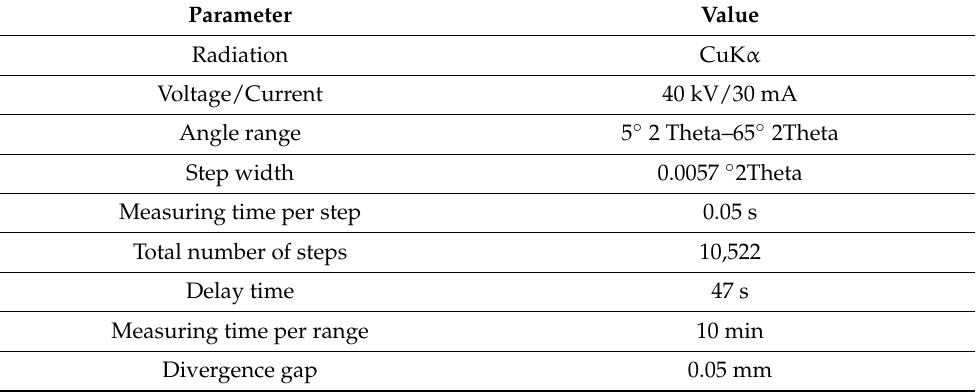
Table 2. XRD-properties used in this